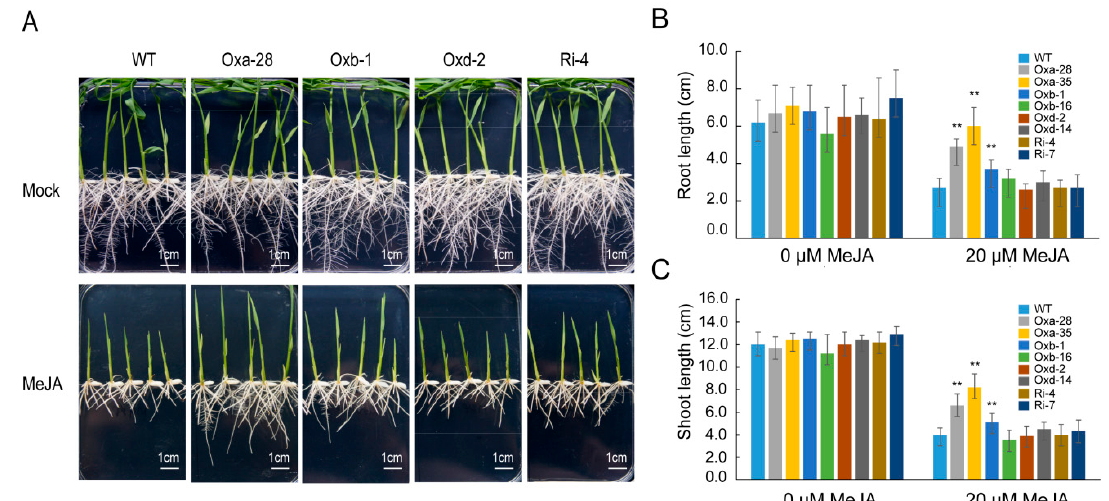
Figure 5. OsJAZ13 functions in jasmonate signaling. ( A ) Overexpression of OsJAZ13a exhibited the increased JA-insensitivity phenotype, and OsJAZ13b showed in slight JA-insensitivity; OsJAZ13d and suppression of OsJAZ13 resulted in JA-sensitivity phenotype similar to wild-type plants. The photograph indicated the phenotypes of seven-day-old seedlings of wild-type (WT) and transgenic lines grown on MS medium with 20 µM MeJA or under normal conditions. Scale bars = 1 cm. ( B,C ) Quantification of MeJA-induced growth inhibition of transgenic and WT plants. Data are the mean ± SD ( n = 10 seedlings per genotype). Asterisks indicate significant differences in root and shoot length ( ** p < 0.01, Student’s t -test) in comparisons with WT grown in the absence or presence of MeJA. Oxa-28 and Oxa-35 represent overexpression lines of OsJAZ13a ; Oxb-1 and Oxb-16 represent overexpression lines of OsJAZ13b ; Oxd-2 and Oxd-14 represent overexpression lines of OsJAZ13d ; and Ri-4 and Ri-7 represent antisense suppression lines of OsJAZ13 . All experiments were performed for three independent biological repeats.